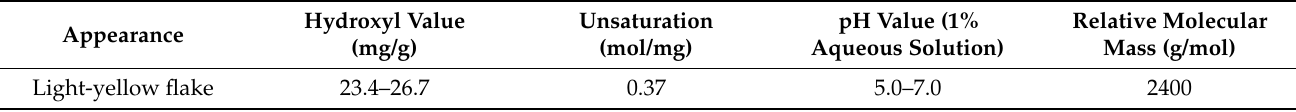
Table 2. Main physicochemical parameters of